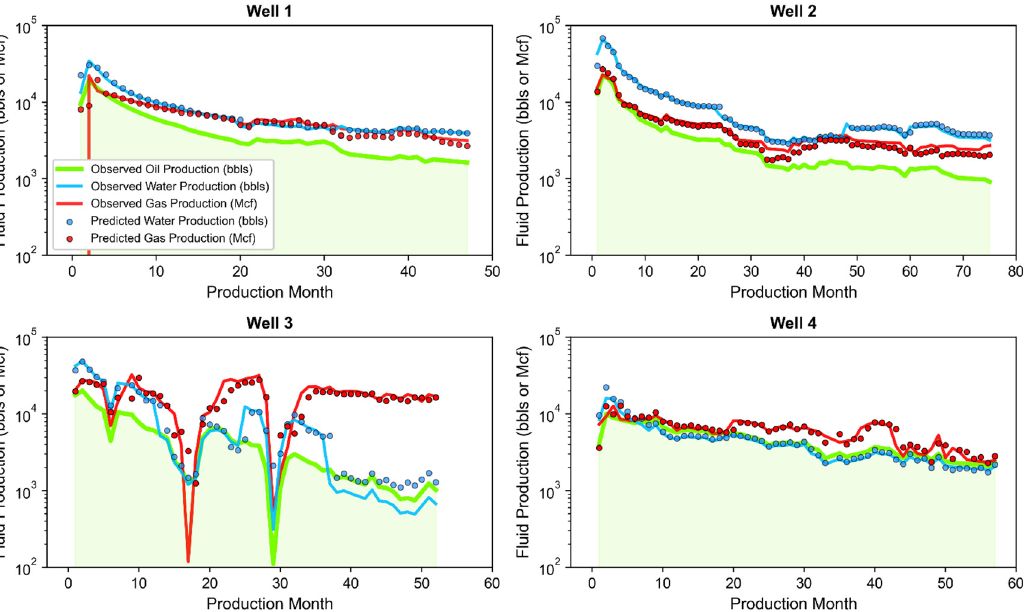
Figure 11. Replication of production history using the joint associated fluid production model for four test dataset wells.